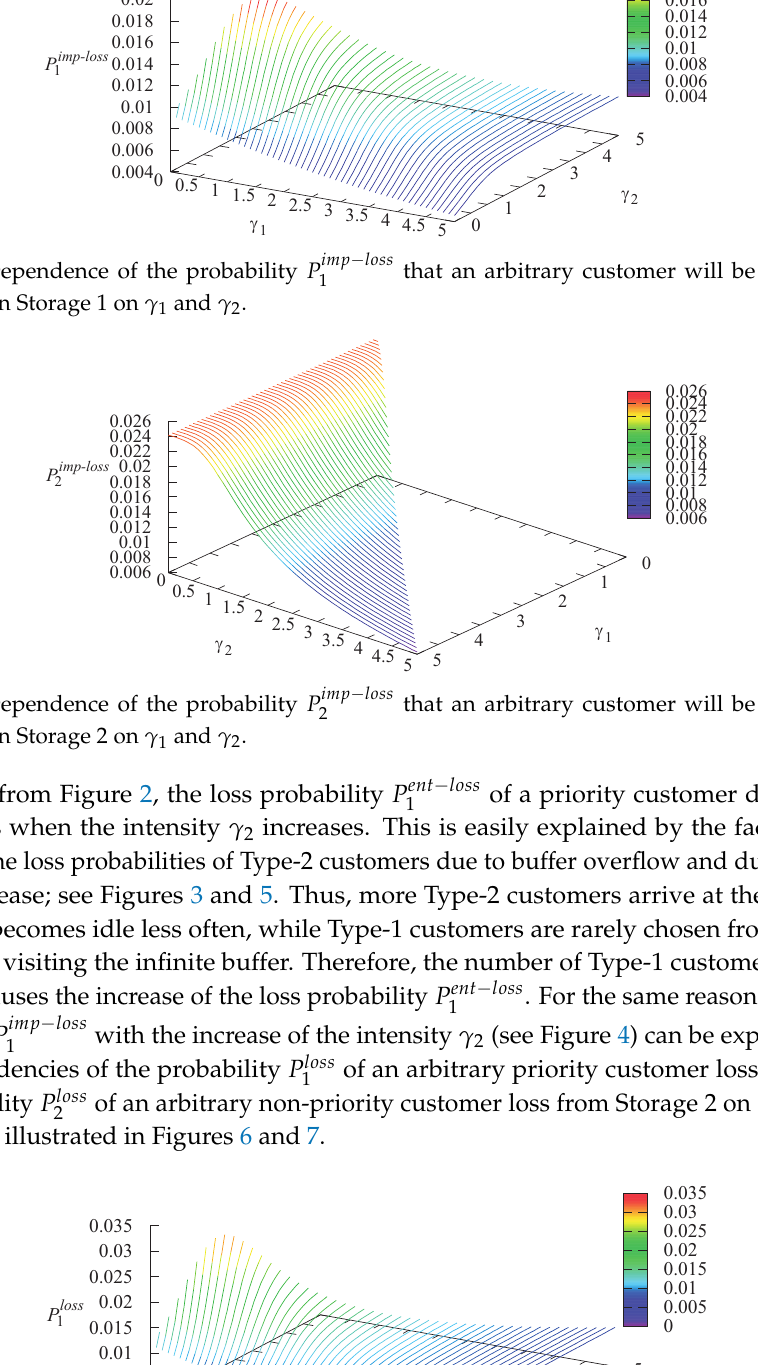
of an arbitrary priority customer loss from Storage 1 on 1